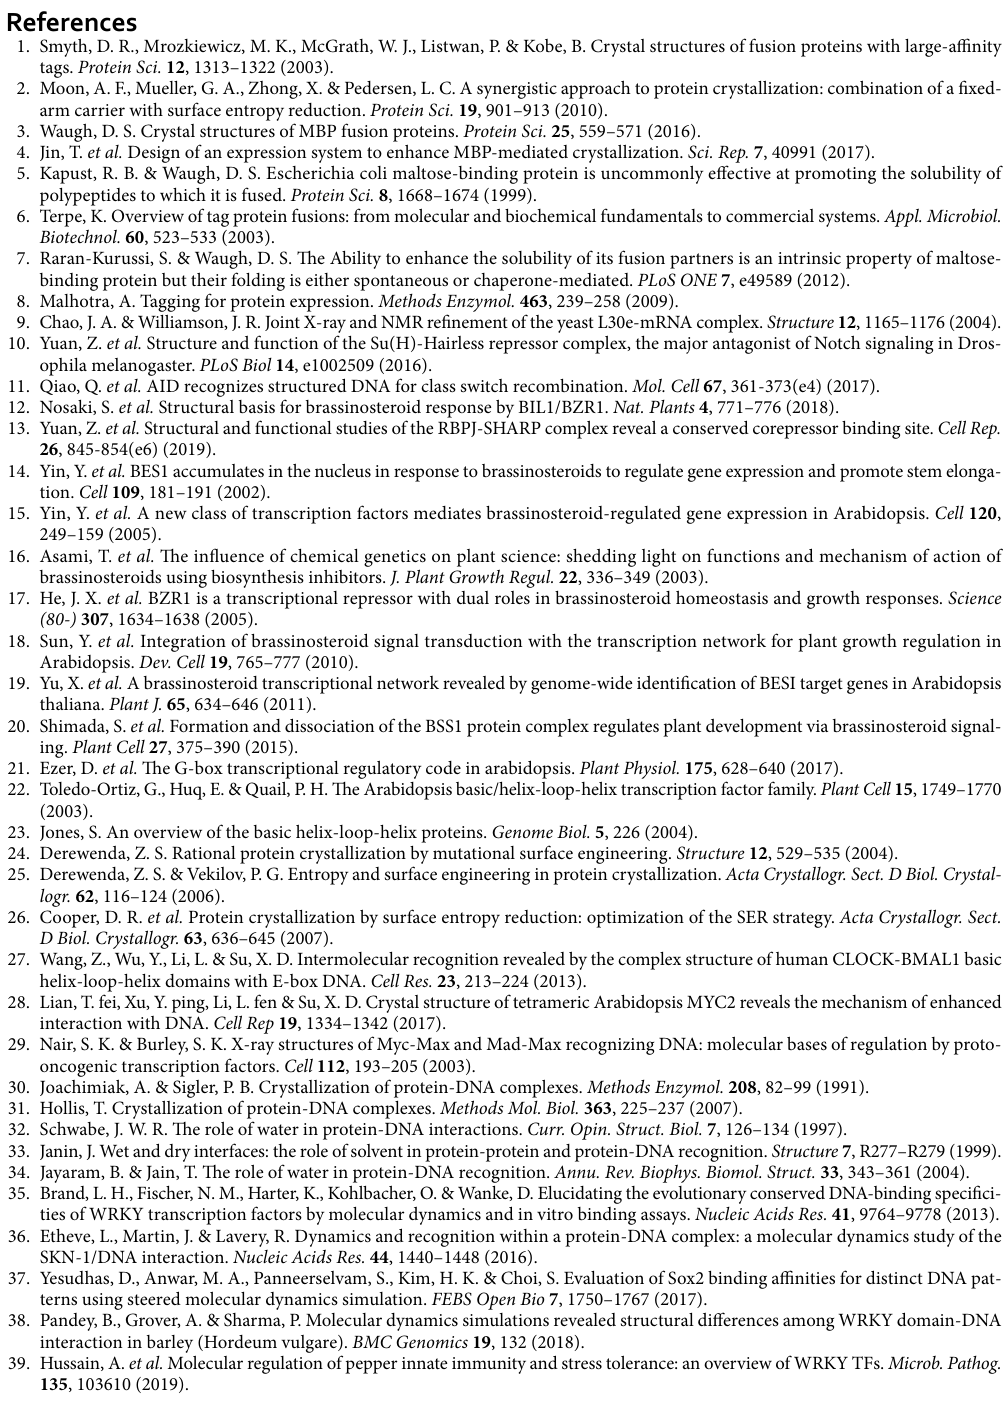
used as the initial structure of the free-energy perturbation calculation. The calculations were repeated six times with different initial velocities. C 1 or A 2 of the first nucleotide chain was altered in the first three calculations, and C 1 or A 2 of the second nucleotide chain (or equivalently, G 6 or T 5 of the first nucleotide chain) was altered in the last three calculations. The average and standard deviation of the binding free-energy difference values obtained from the six calculations are